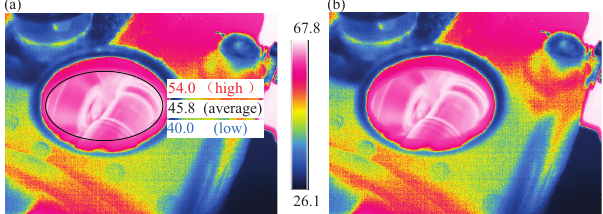
Figure 6. IRT images extracted from an infrared thermal video: ( a ) marked meshing area for reference ( b ) the raw IRT